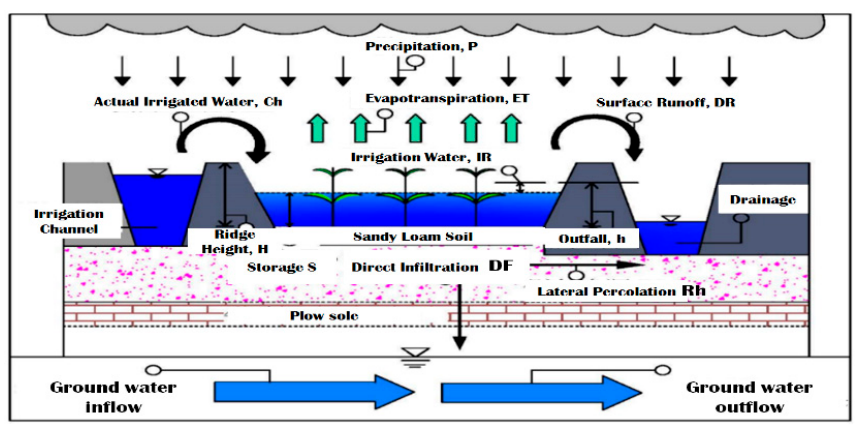
Figure 2. Conceptual model of field water balance.